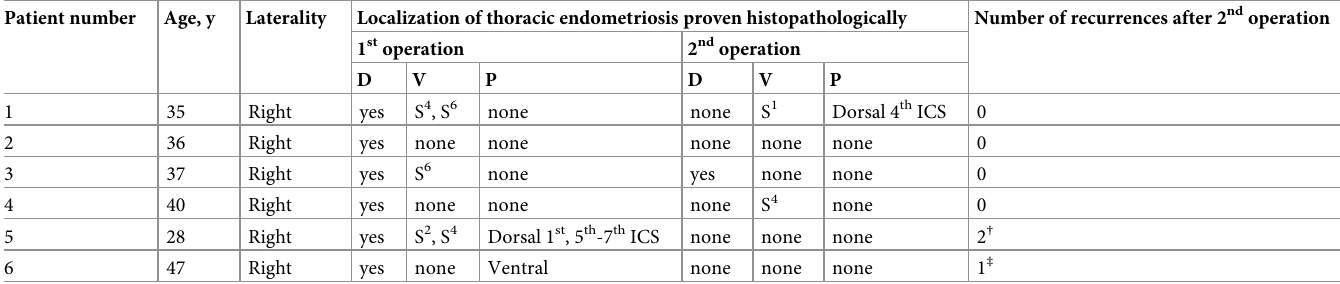
Table 3. Detailed characteristics of the 6 patients who received reoperations. Patient